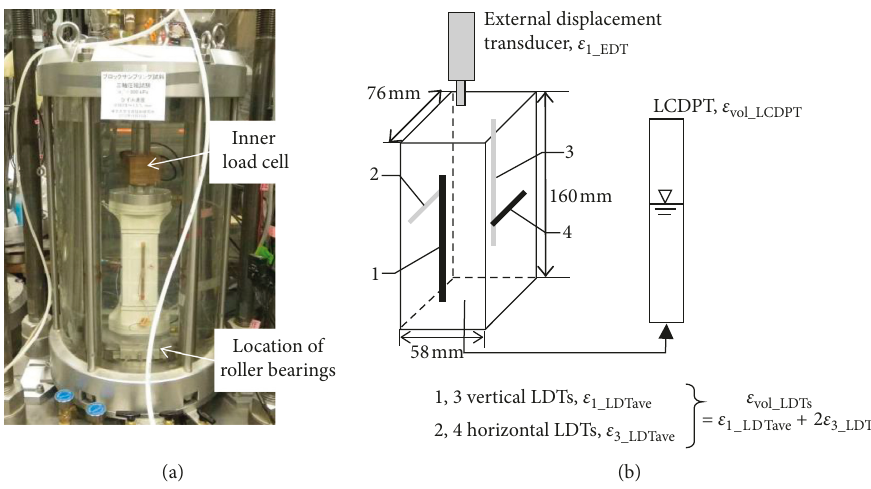
Figure 2: (a) Picture of triaxial apparatus; (b) schematic figure of specimen and deformation